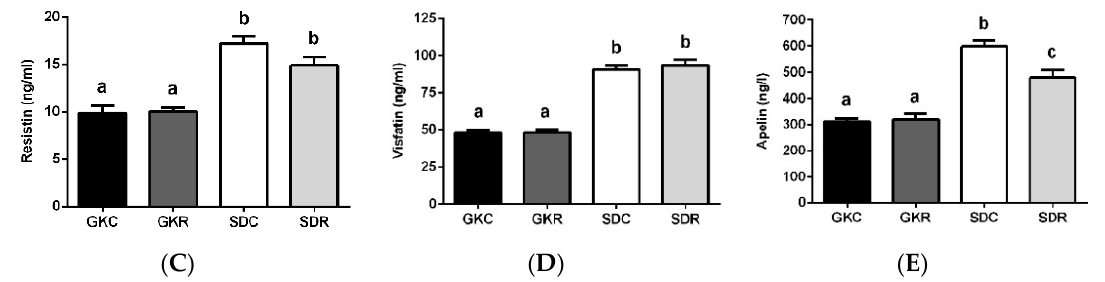
Figure 2. Effects of resveratrol on blood adipokine levels in GK and Sprague–Dawley (SD) rats. Adiponectin ( A ), leptin ( B ), resistin ( C ), visfatin ( D ), apelin ( E ). GKC—Goto-Kakizaki control rats, GKR—Goto-Kakizaki resveratrol-treated rats, SDC—Sprague–Dawley control rats, SDR—Sprague–Dawley resveratrol-treated rats. Results are expressed as the means ± SEM from 10 rats in each group. Values with different letters are significantly different at p < 0.05.